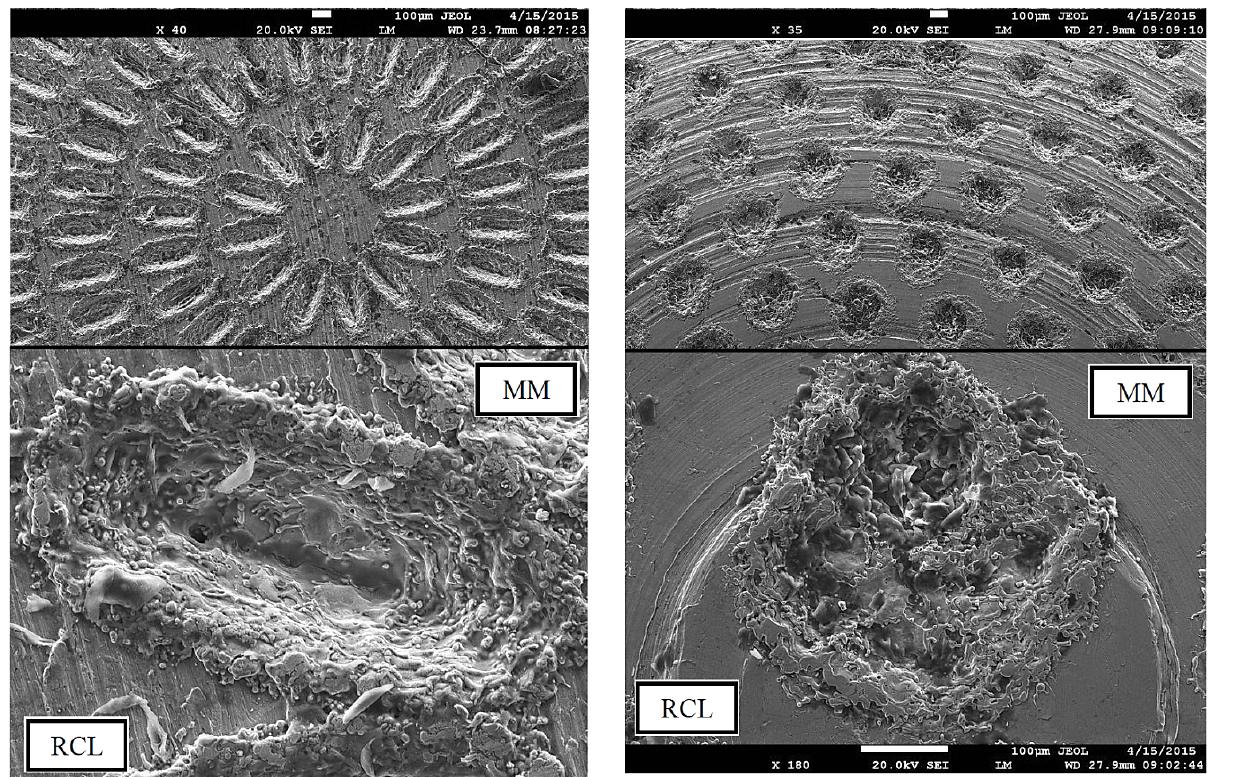
sion. Surface texture density is slightly affected by origi- nated recast layer. Slightly pooling of texture depression has been recorded in a certain places of ablated surface (as it is shown on Fig. 7).